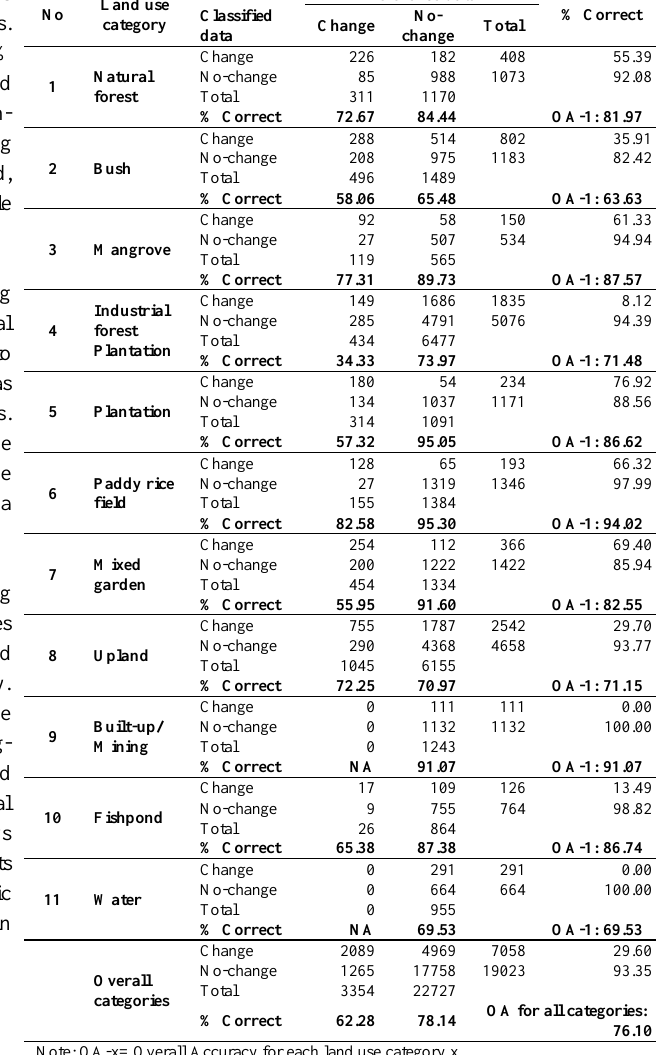
Table 2. The result of validation on the actual land use change detection for each land use type